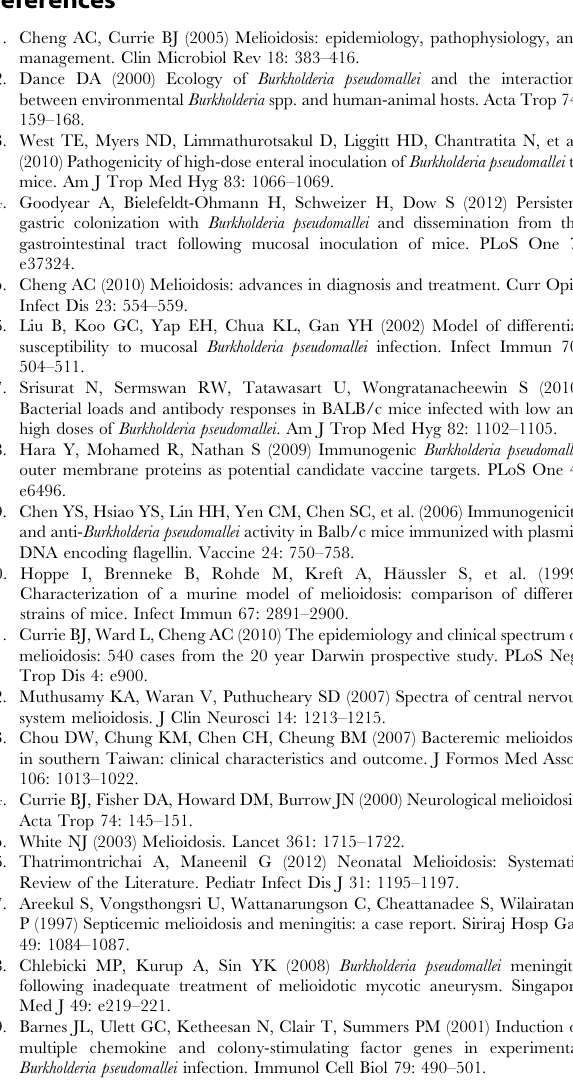
experiments. The (*) symbol indicates p , 0.05 compared with the data derived from day 5 post-infection. Figure S5 Comparison of survival rates and bacterial burdens in organs from mice intravenously infected with B. pseudomallei vgh19 and GFP. Survival rates (100%) were recorded on the indicated day for BALB/c mice (n= 10, each group) infected with B. pseudomallei vgh19 (50 CFU, dark gray) or GFP (50 CFU, light gray) (A). At the indicated times, individual mice with melioidosis (each experiment, n= 6; duplicate experi- ments) were sacrificed, and their bacterial burdens in the liver (B) and spleen (C) were determined. The limits of detection were 10 and 250 CFU/g for the liver and spleen, respectively. Table S1 Clinical score parameters, assessed values and weight score. Table S2 Primary antibodies used for flow cytometry in this study.